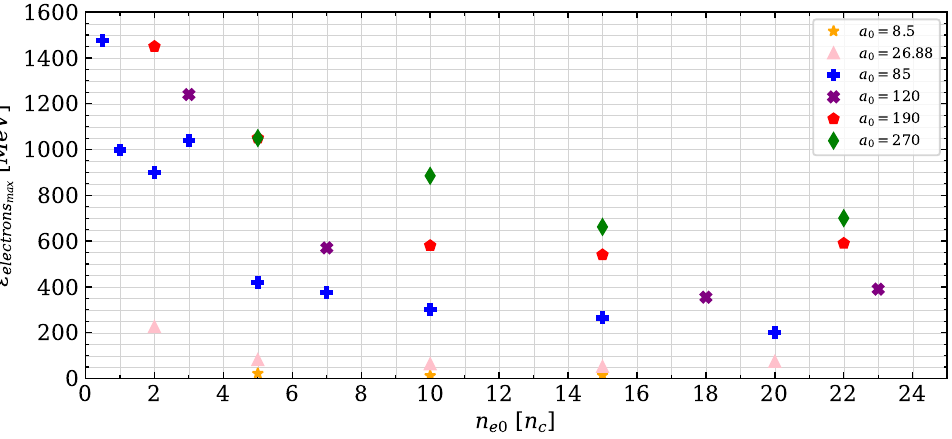
Figure 7. Maximum electron energy at the optimum target thickness vs. target density for various laser pulse intensities. Target parameters: L y = 30 µ m. Laser parameters: λ = 1 µ m, τ = 6 t 0 and w 0 = 12.5 µ